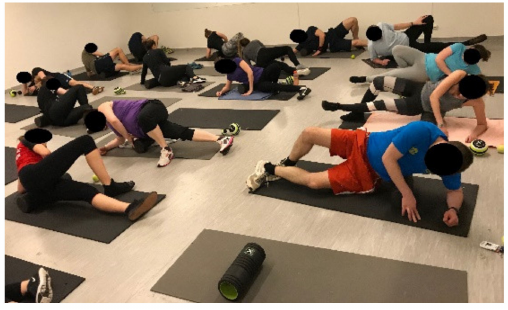
Figure 2. Self-myofascial release.